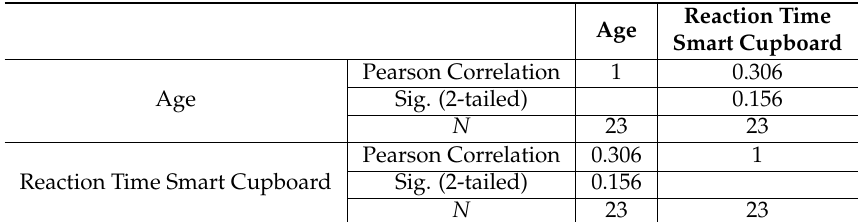
Table 5. Correlation between the reaction time and participant age in the smart cupboard test.